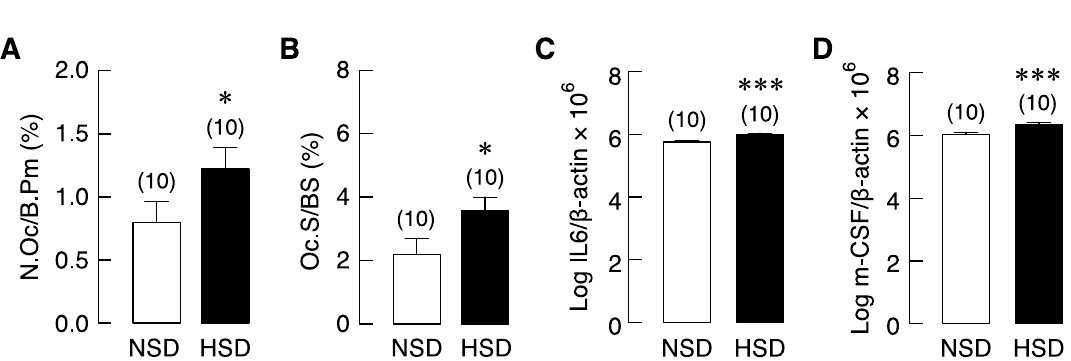
Figure 7. Bone histomorphometric analysis of bone resorption markers of tibiae and the mRNA expression levels of osteoblast-derived osteoclastogenic factors in long bone (humerus and radius) of NSD and HSD. ( A ) Percentages of osteoclast number per bone perimeter (N.Oc/B.Pm) and ( B ) osteoclast surface per bone surface (Oc.S/BS), and expression of ( C ) IL-6 and ( D ) m-CSF. The mRNA expression of each gene was normalized by β-actin expression. Numbers in parentheses are numbers of animals in each group. *P < 0.05, ***P < 0.001 compared to